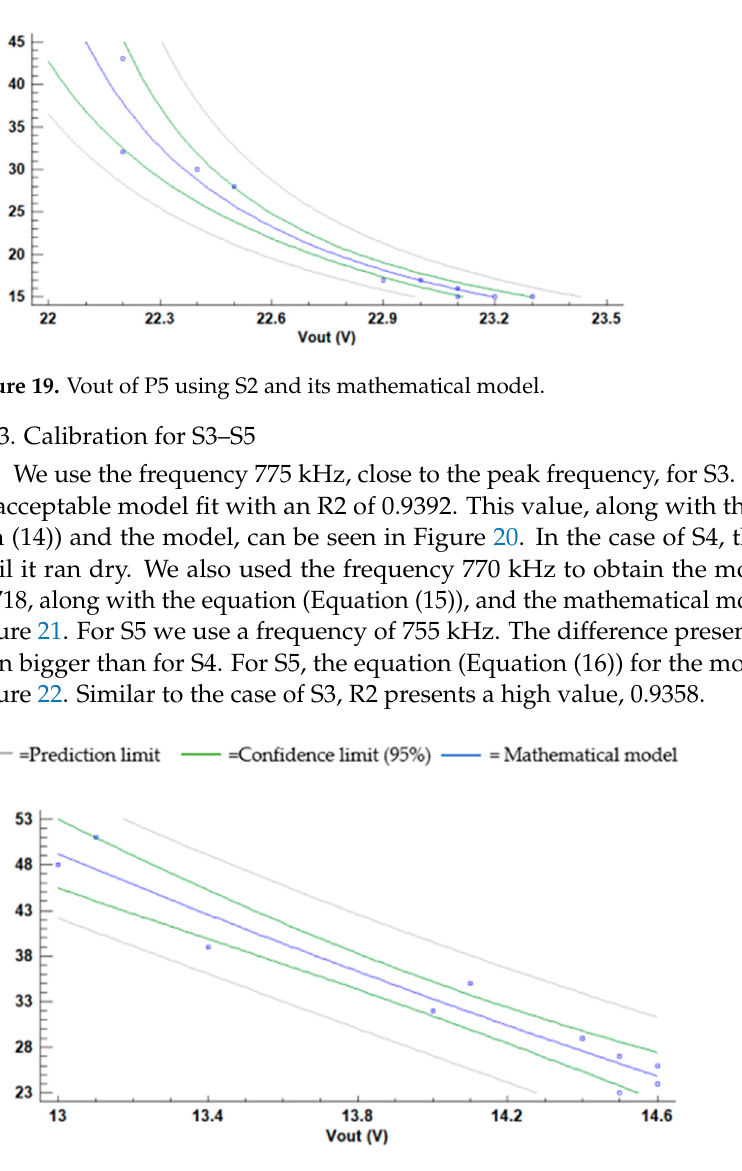
Figure 20. Vout of P8 using S3 and its mathematical model.